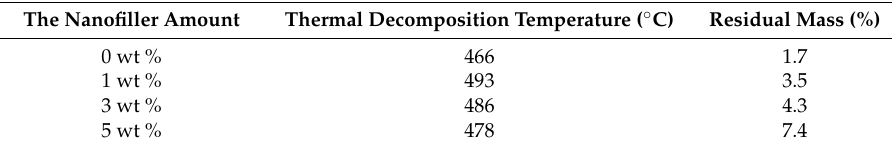
Table 1. Thermal properties of the nanofibrous adsorbents produced in this